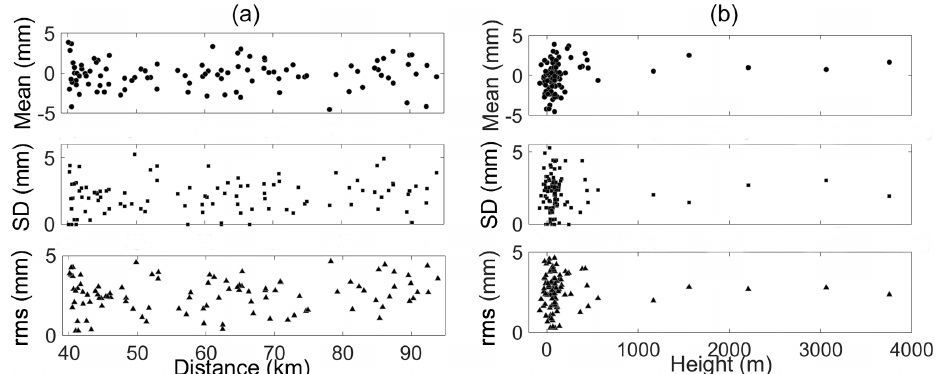
Figure 6. The statistics of PWV differences between HY-2A and ground-based GNSS with respect to (a) the distance between HY-2A footprint and GNSS stations and (b) the station